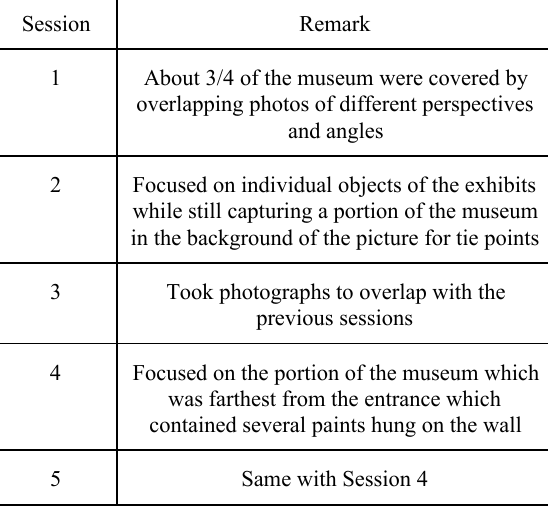
Table 5. Remarks on sessions of image